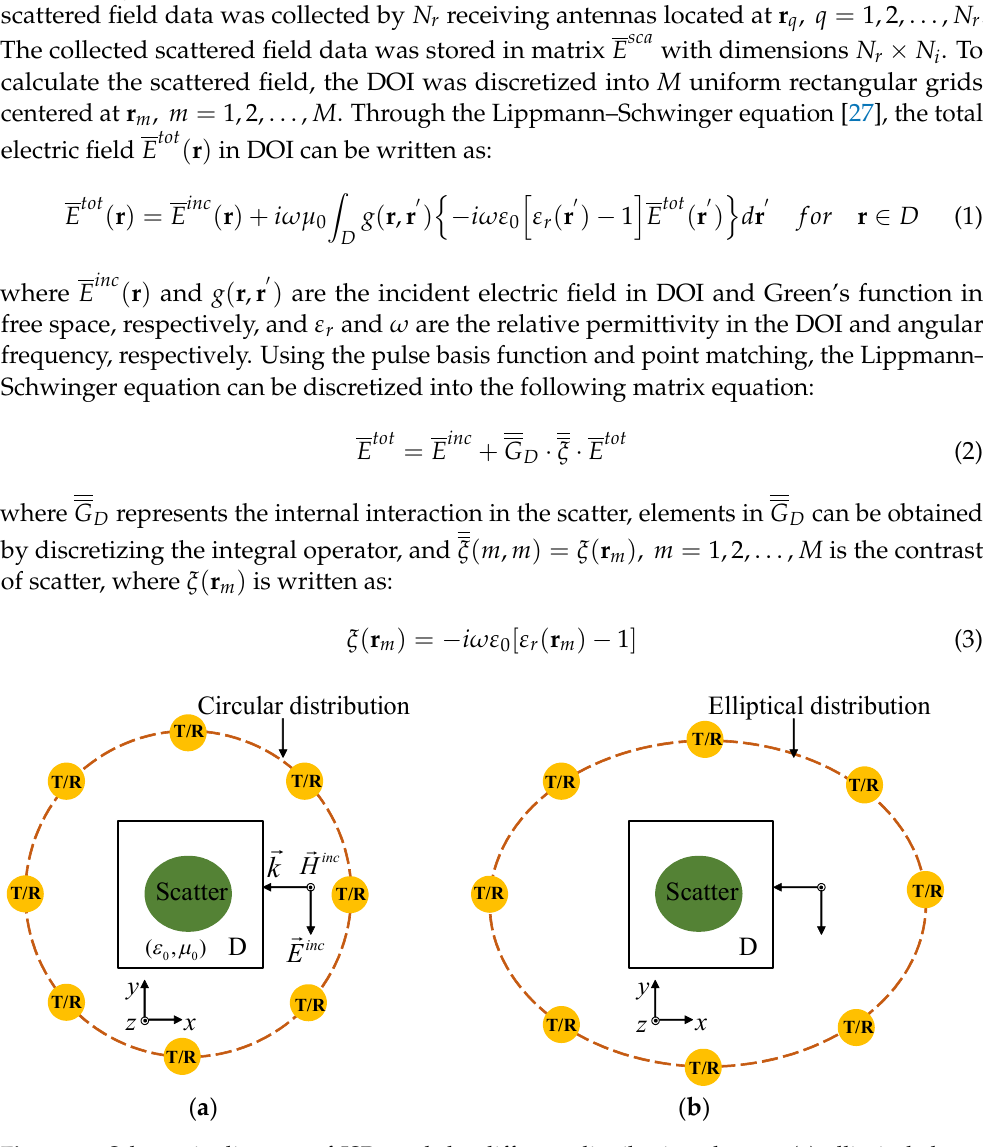
Figure 1. Schematic diagram of ISPs and the different distribution shapes: ( a ) elliptical shape; ( b ) circular shape.